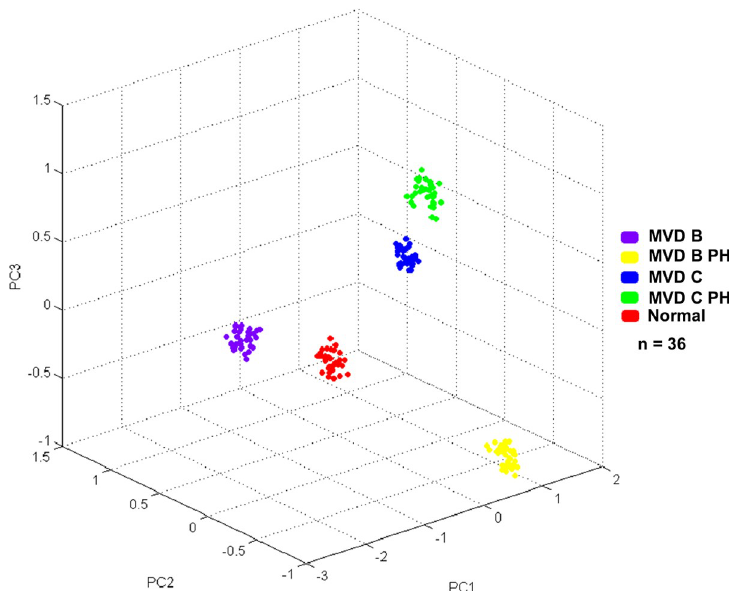
Fig 1. Three-dimensional principal component analysis (3D-PCA) scatterplot of dogs in the MVD stage B2 (MVD B), MVD stage B2 with PH (MVD B PH), MVD stage C (MVD C), MVD stage C with PH (MVD C PH), and normal control